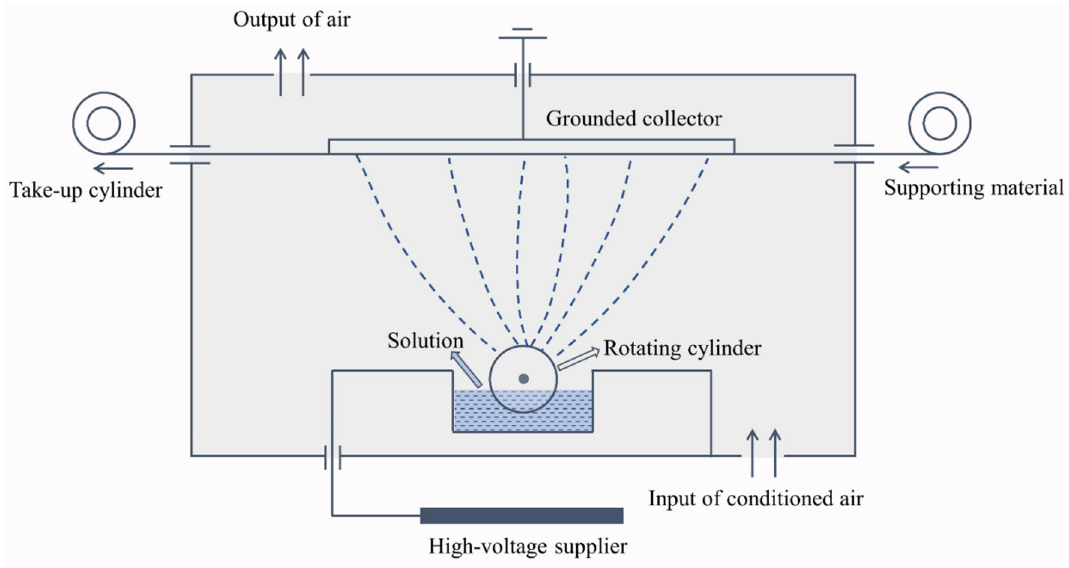
Figure 1. Schematic diagram of needle-less electrospray.